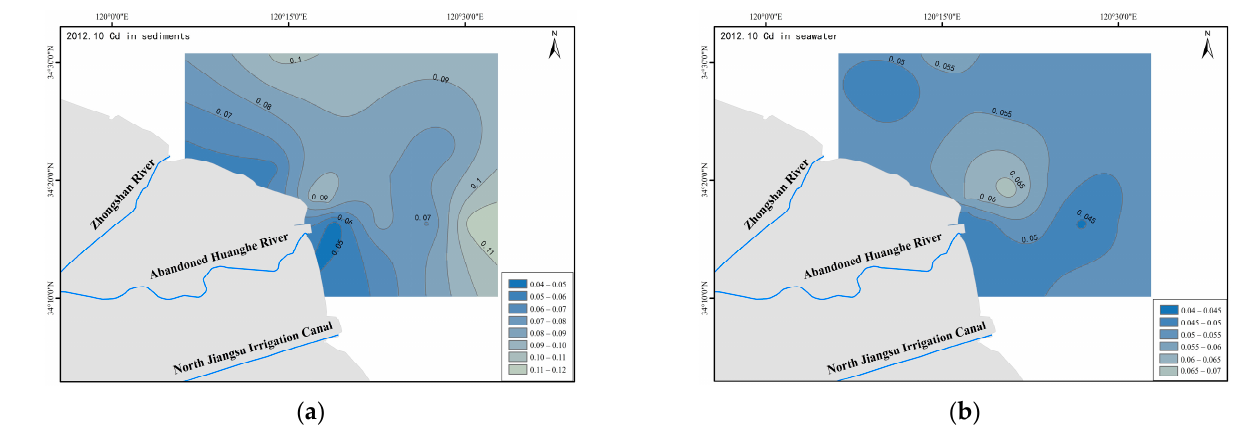
Figure 12. Spatial distribution of Cd in the sediment ( a ) and seawater ( b ) in 2012.